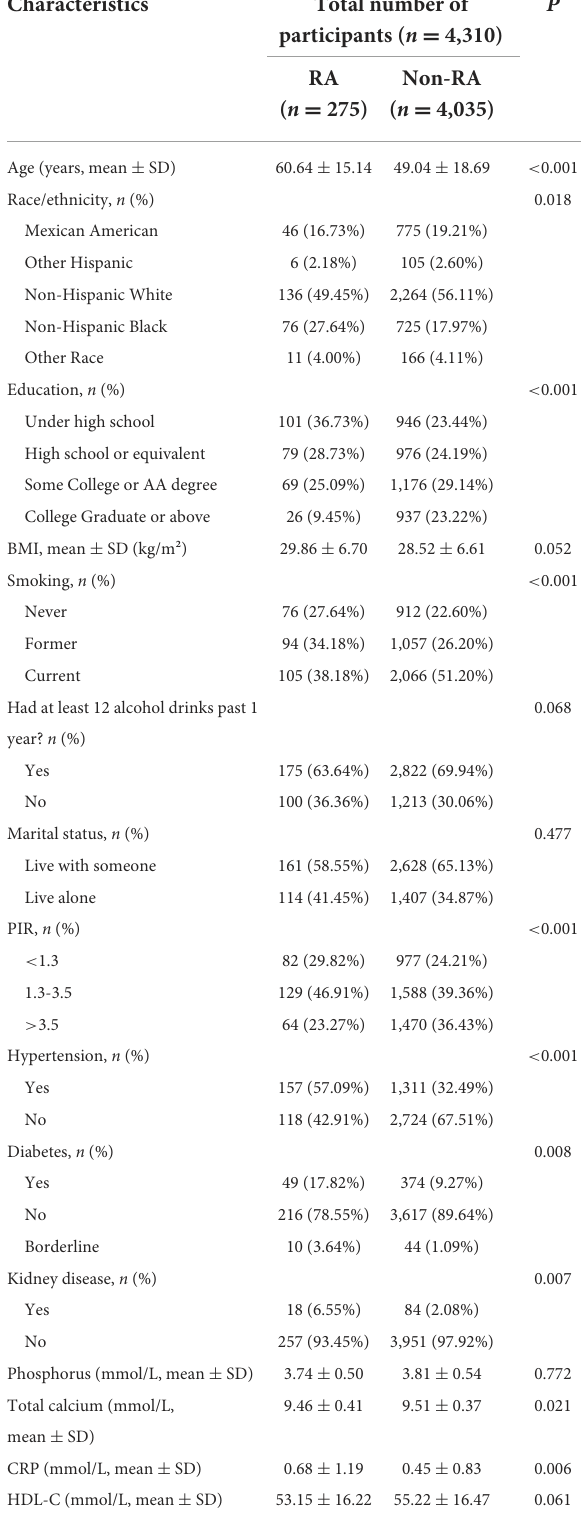
TABLE 1 Baseline characteristics of study participants with or without rheumatoid arthritis in the NHANES 2003–2006.